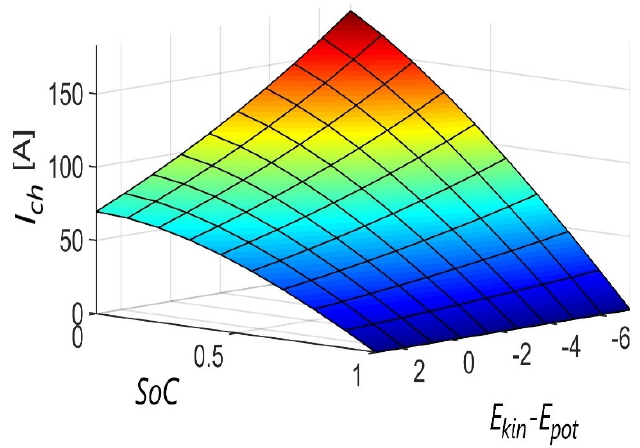
Figure 9. Supercapacitor charging current surface.